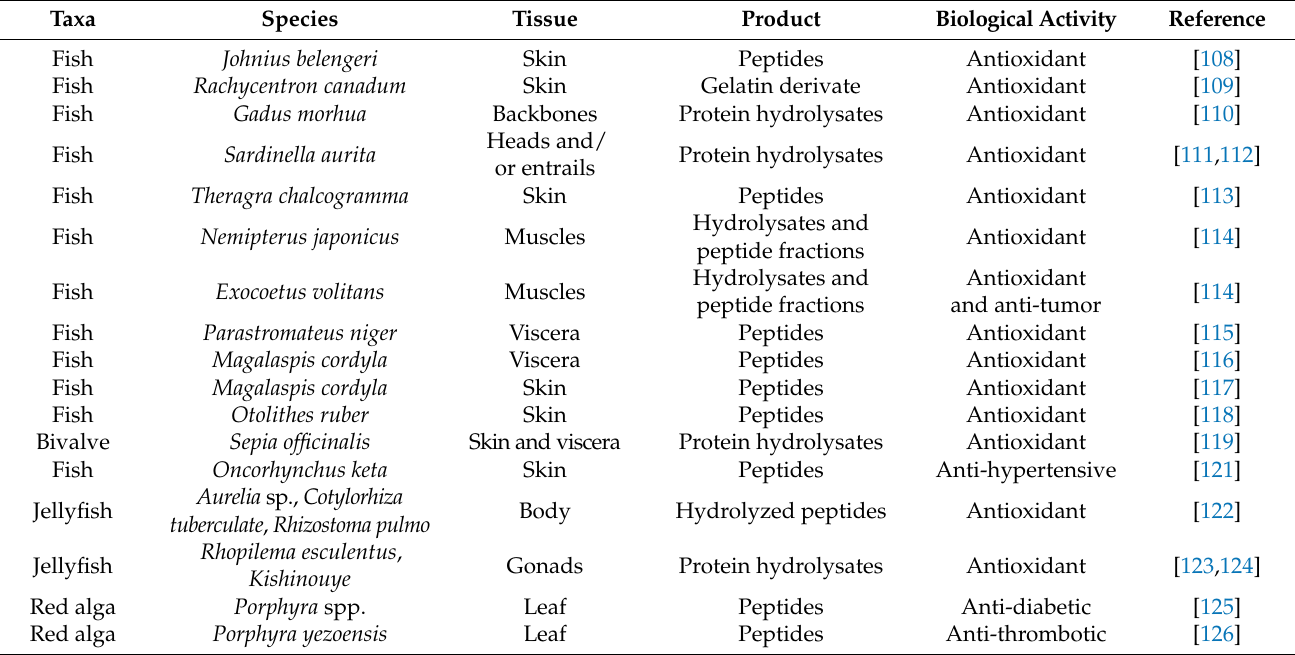
Table 3. Proteins and protein hydrolysates from seafood wastes, together with the taxa, species and tissue from which they were isolated, and their biotechnological